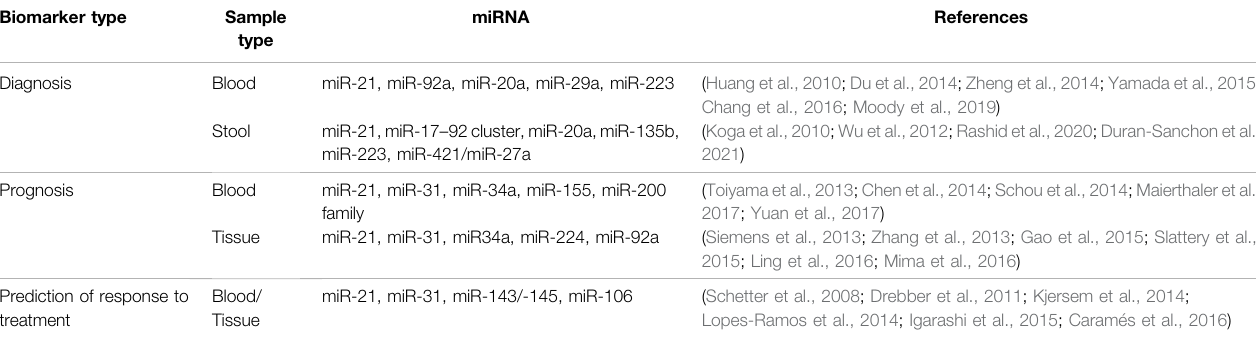
TABLE 1 | List of most promising miRNA biomarkers in Colorectal